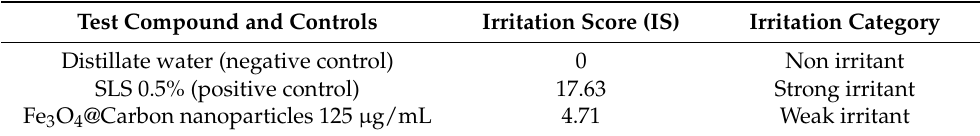
Figure 10. The irritation potential using the HET-CAM method. Stereomicroscope images show the chorioallantoic membrane before (t 0 ) and 300 s after application (t 5 ) of 300 µ L of the test sample of Fe 3 O 4 @Carbon nanoparticles at a concentration of 125 µ g/mL and control samples (distilled water as a negative control, SDS 0.5% as a positive control); scale bars represent 500 µ m. The black particles observed in the images represent the Fe 3 O 4 @Carbon sample. Table 2. Irritation score and type of effect induced by Fe 3 O 4 @Carbon nanoparticles at a concentration of 125 µ